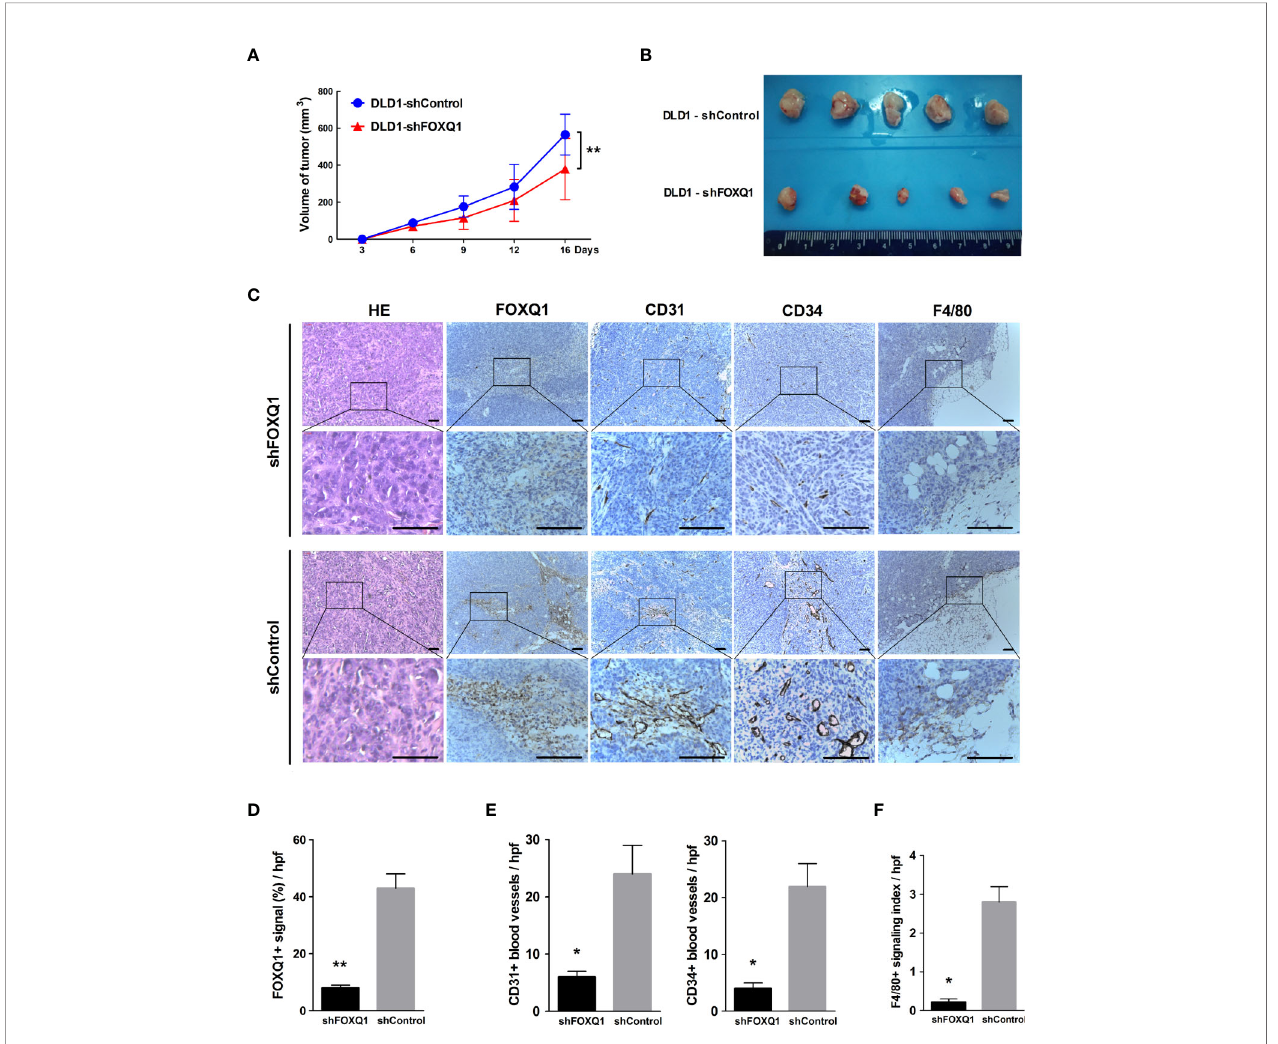
FIGURE 4 | Inhibition of FOXQ1 results in inhibited tumor angiogenesis and intratumoral macrophage in fi ltration in vivo. Athymic nu-/nu-mice were implanted with 1 × 10 7 DLD1-shFOXQ1 or DLD1-shControl cells subcutaneously (n = 5 per group); tumor volume was documented by caliper measurement. (A) FOXQ1 inhibition signi fi cantly suppressed the tumor proliferation capacity in vivo . (B) Resulting plugs were harvested and processed for IHC staining. (C) Representative HE staining images of tissue sections and IHC staining for FOXQ1; analysis of microvessel density (MVD) by IHC staining for CD31 or CD34; detection of the content of macrophages by IHC staining for F4/80. Scale bars represent 100 m m. (D) Reduction of FOXQ1 in dissected tumor tissue from the DLD1-shFOXQ1 group as determined by IHC staining quanti fi cation. (E) MVD was determined by counting the number of CD31 + or CD34 + vessels in tumor specimens; the number of CD31 + or CD34 + blood vessels was signi fi cantly decreased in DLD1-shFOXQ1 compared with DLD1-shControl. (F) Intratumoral macrophage quanti fi cation was determined by scoring for F4/80 staining intensity and distribution; DLD1 cells with downregulated FOXQ1 signi fi cantly decreased the number of in fi ltrating macrophages. 5 random hpf/section, 2-3 representative sections/plug, 5 plugs/group were scored for positive signal quanti fi cation. * P <0.05, ** P <0.01 signi fi es a signi fi cant difference between the indicated groups (two-tailed, unpaired Student ’ s t -test). HE, Hematoxylin and eosin; IHC, immunohistochemical; hpf, high-powered fi